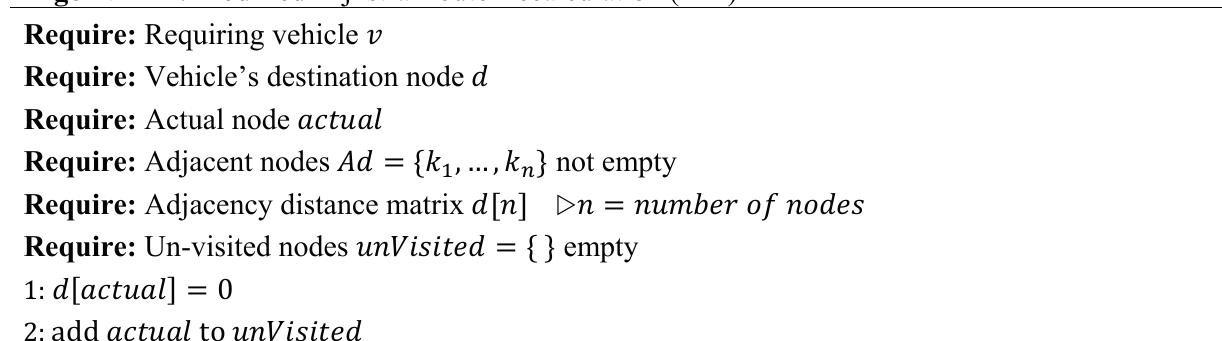
Algorithm 2. Modified Dijkstra Route Recalculation (MD)